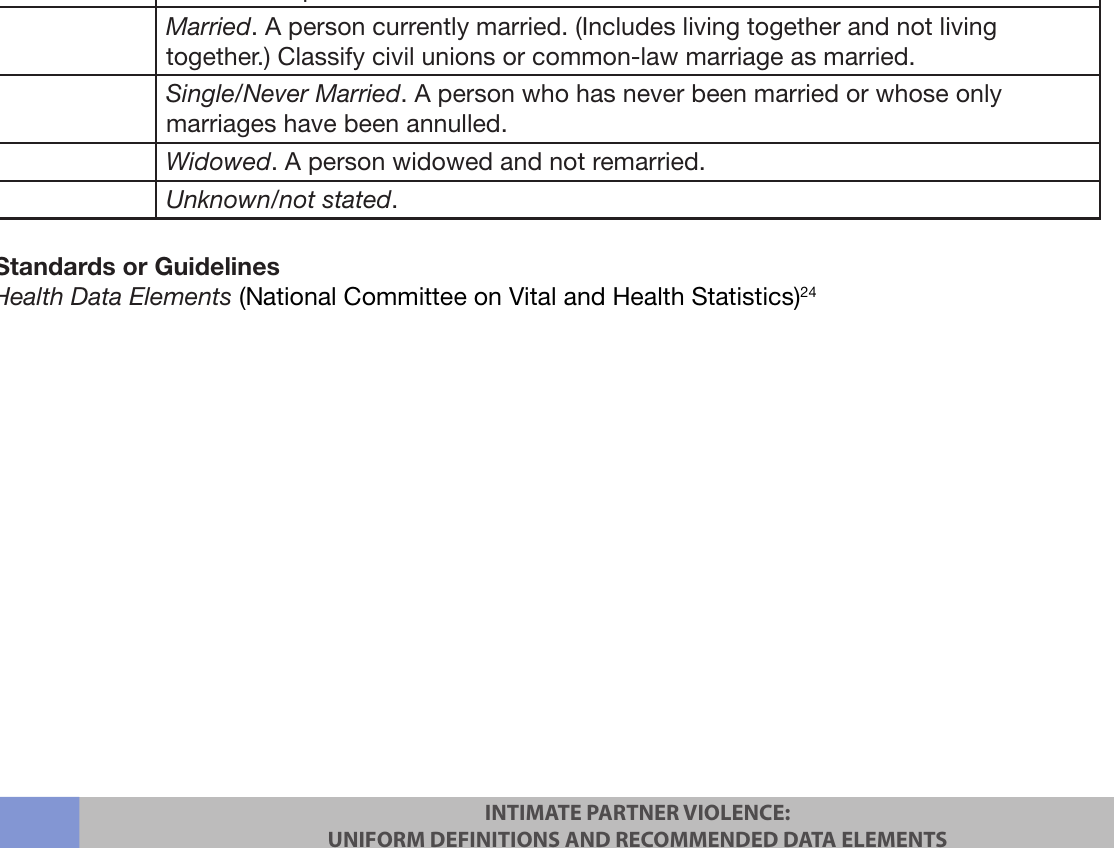
INTIMATE PARTNER